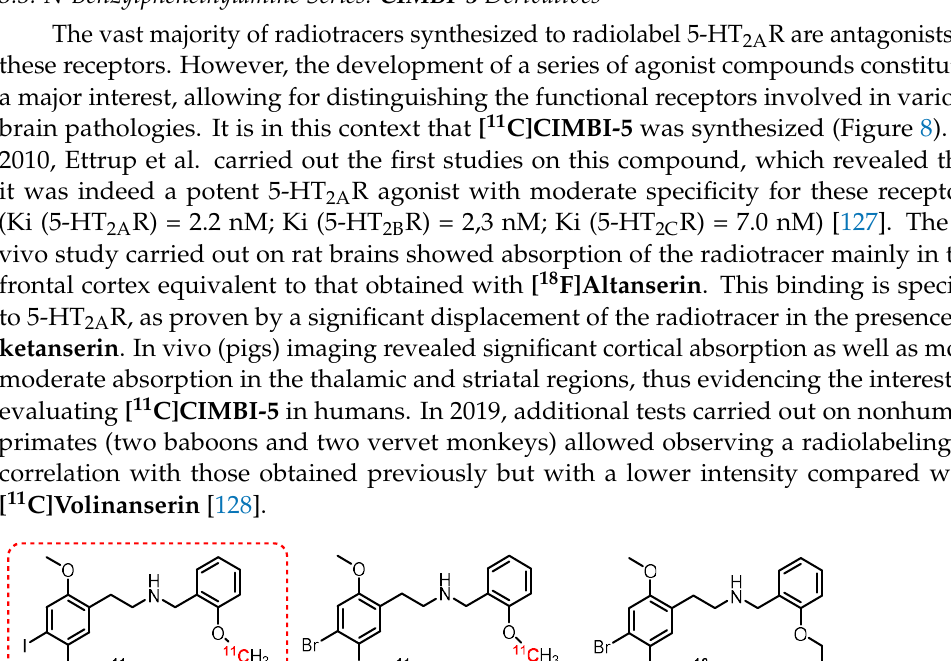
2A R radiotracers.